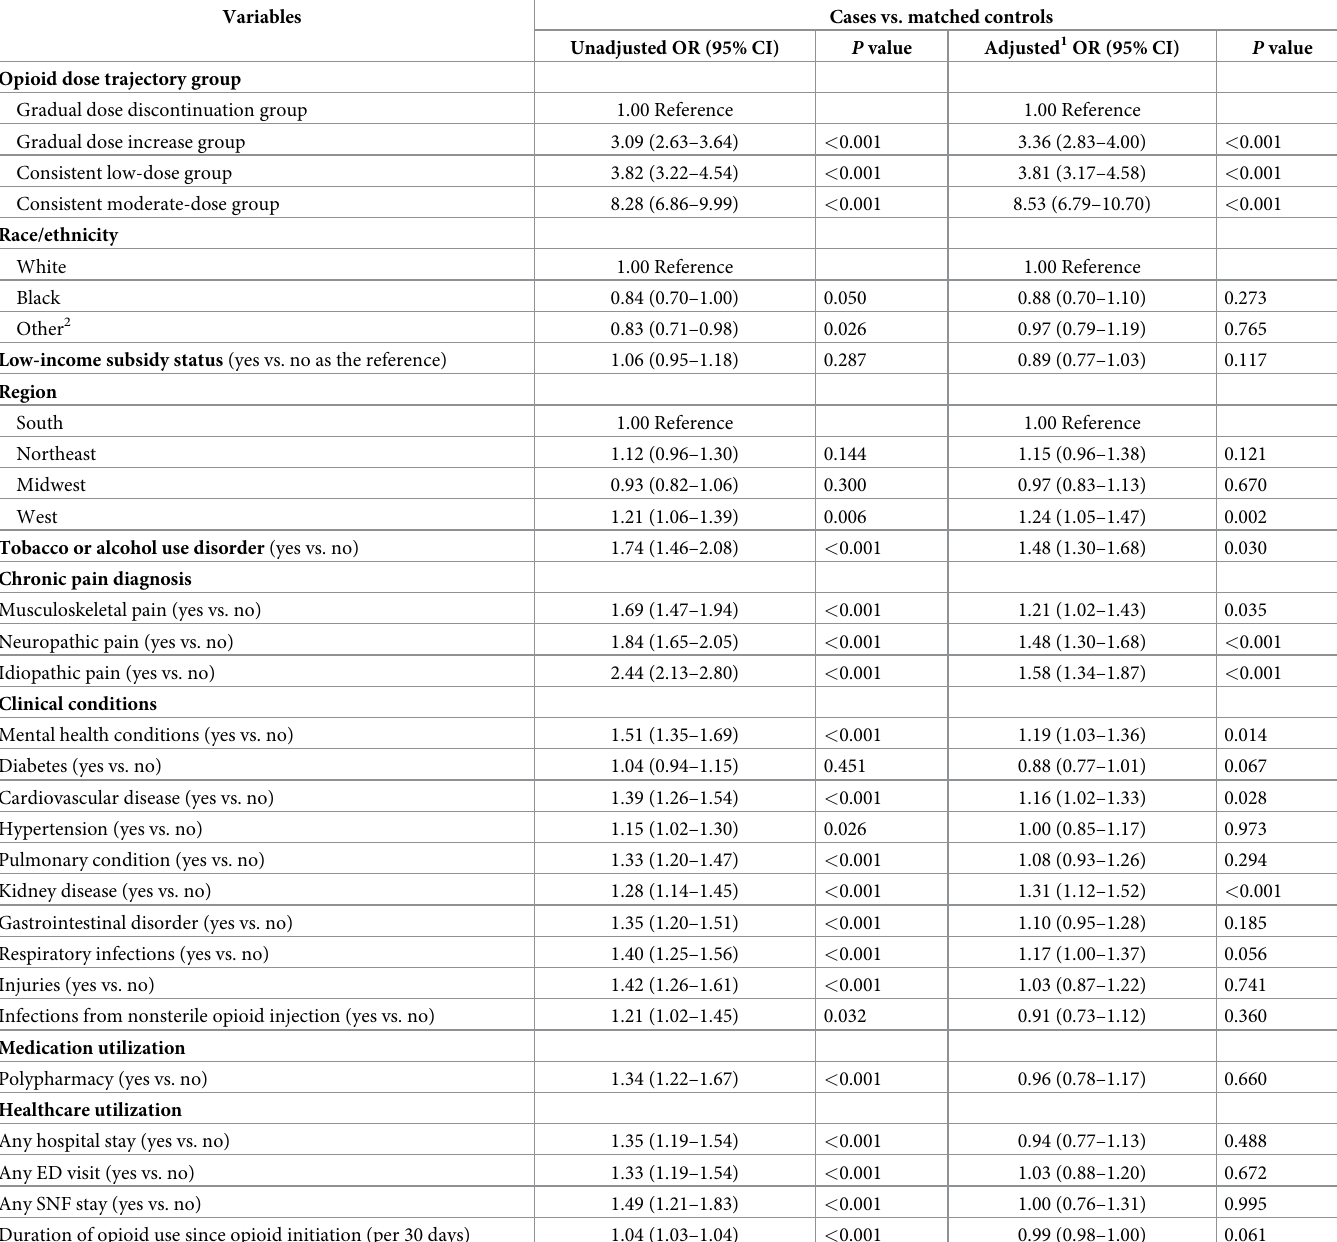
Table 4. Unadjusted and adjusted association between trajectories of prescription opioid dose and risk for ORAEs.